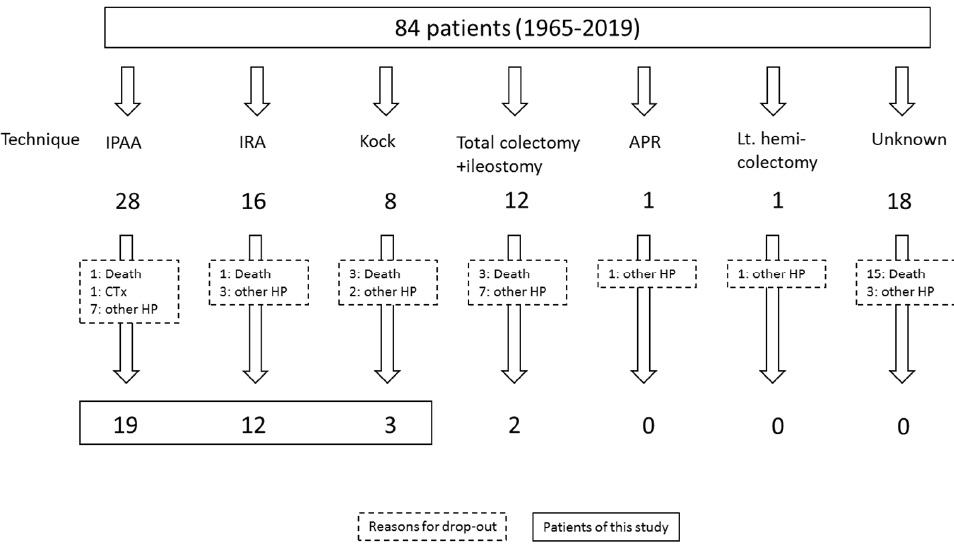
Figure 4. Patient flow in this